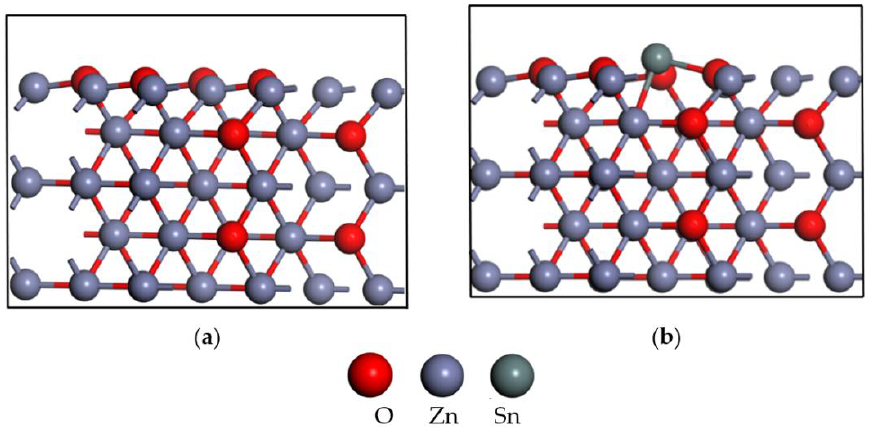
Figure 1. Optimized atomic side-view of ( a ) pure ZnO (101) surface and ( b ) Sn-doped ZnO (101) surface.